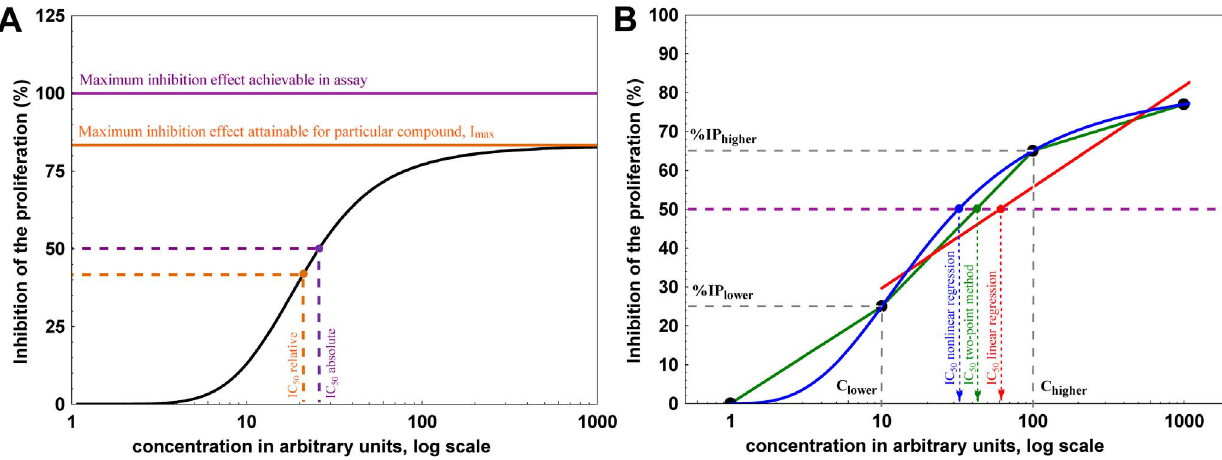
Figure 2. Graphical explanation of data analysis algorithms used in Cheburator. ( A ) Two types of IC 50 which can be estimated by the software. Absolute IC 50 is defined as the concentration of tested compound which results in 50% inhibition of cell growth as defined by assay controls (pink lines). Relative IC 50 is defined as the concentration of tested compound which results in half of the maximum inhibition of cell growth attainable for that particular compound (orange lines). I max is defined as upper plateau of the dose-response curve (solid orange line). ( B ) Example of a dose-response curve drawn on the basis of 4 values (black circles). The simple two-point method uses 2 data points bracketing 50% inhibition of proliferation (green lines) to estimate the IC 50 . In the second method, a linear model is built with the intercept and the slope, which are calculated by linear regression analysis using data points which are . 0% and , 100% (red lines). These parameters are later used to estimate IC 50 . In the third method, the software uses all data points to build nonlinear regression model and estimate IC 50 (blue lines). Absolute IC 50 values are shown on this plot, but software can also estimate relative IC 50 in linear and nonlinear regression analysis.